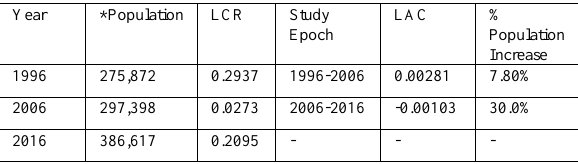
Table 7. LCR and LAC in study area (1996-2016).